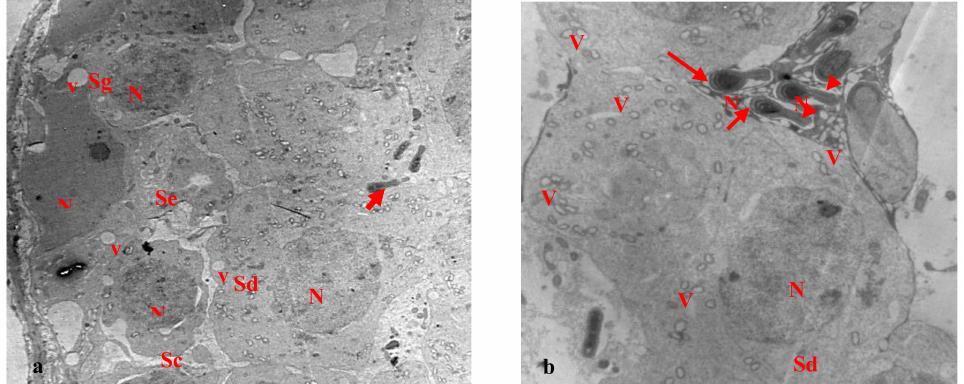
Figure 9. ( a , b ): Electron micrograph of a section of rats’ testis treated with EVOO and paracetamol for 15 days. ( a ) showing normal seminiferous tubule with normal spermatogonia (Sg), primary spermatocytes (Sc), spermatids (Sd) with normal nucleus (N). Sertoli cell (Se) appeared with flatted nucleus. Sperm appeared with elongated condensed nucleus and acrosomal cap (arrow) at the leading point of the head. Notice vacuoles (v) in some cells ( × 2000). ( b ) showing normal spermatids (Sd) and a normal nucleus. Normal sperm appeared with elongated condensed nucleus (N), acrosomal cap (arrow), and flagellum (head arrow). Notice vacuoles (v) in some cells ( × 2000).